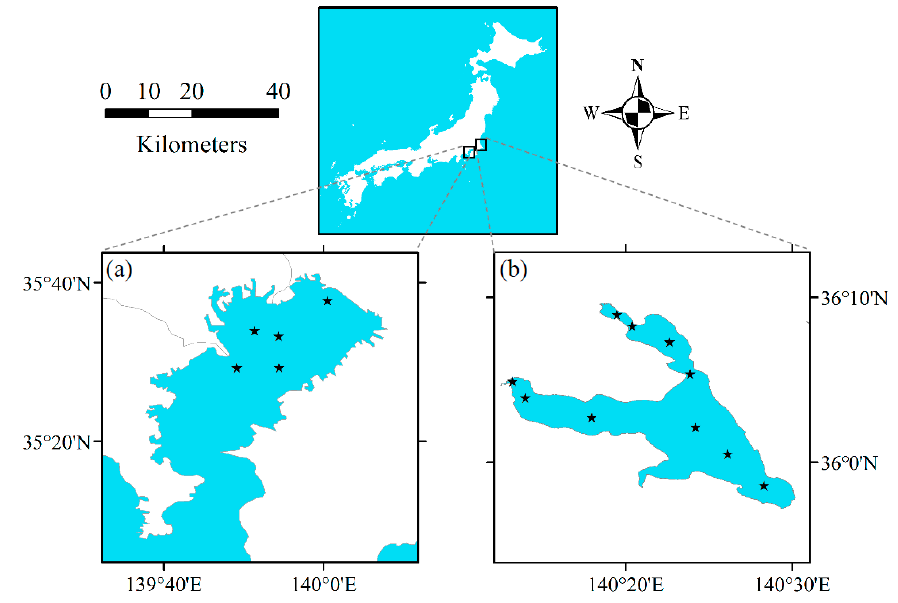
Figure 1. Location of the sampling sites. ( a ) Tokyo Bay; and ( b ) Lake Kasumigaura.